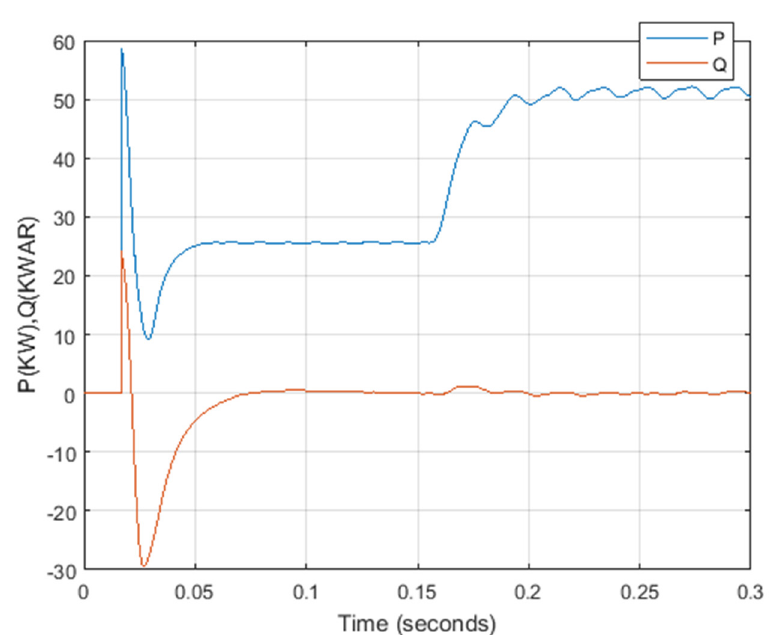
Figure 9. Active and reactive power distribution. The two-phase voltage ab for each two converters is also shown in Figures 10 and 11. Their changes are also noticeable at the moment 0.15 s.